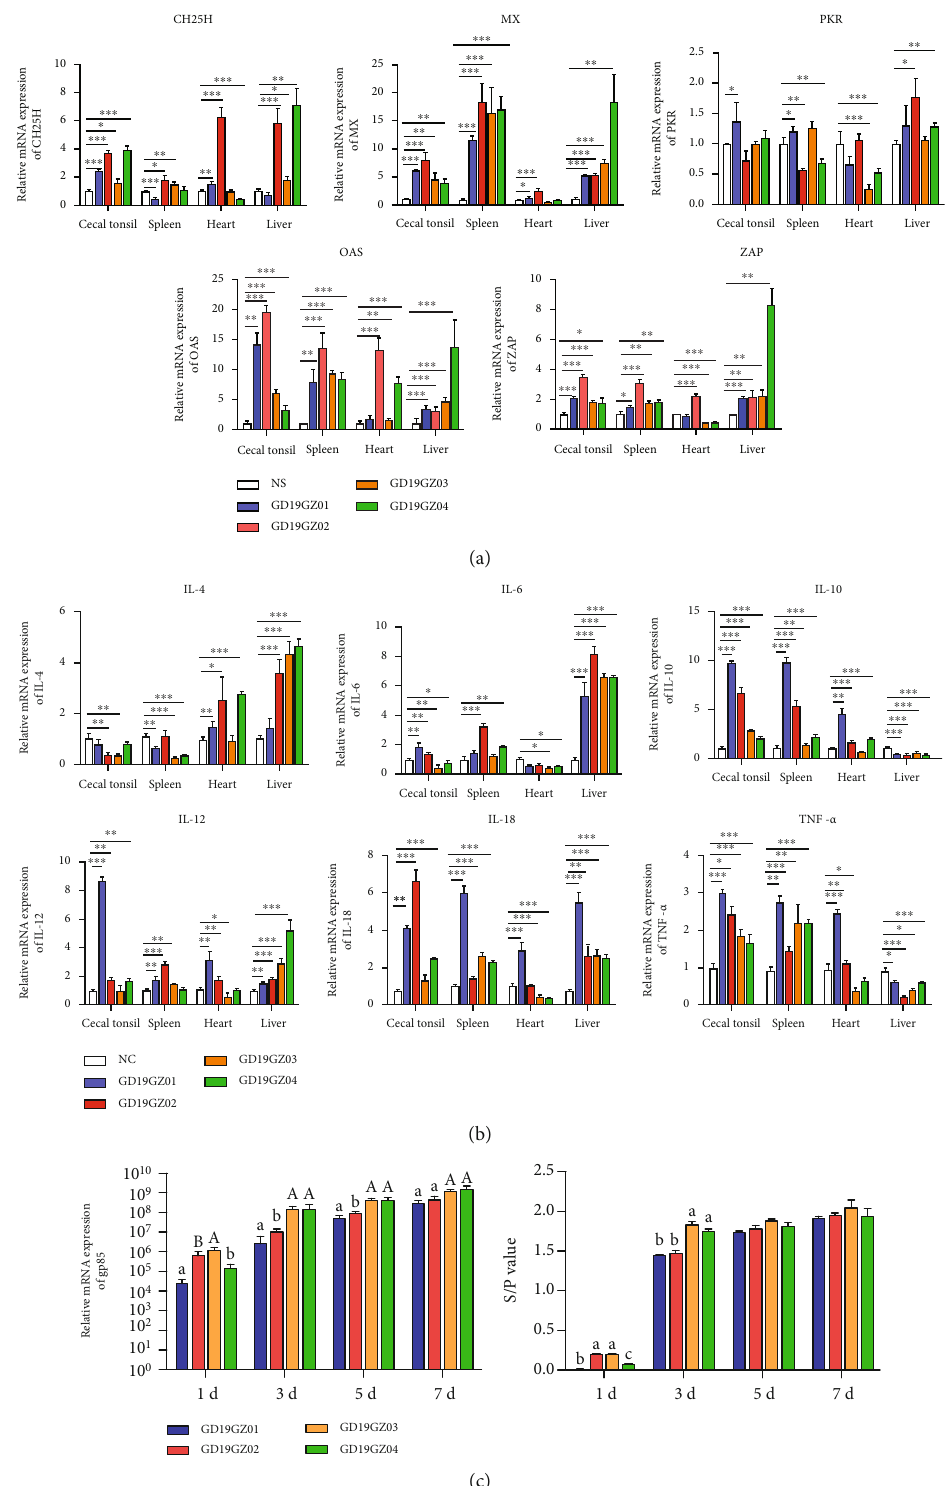
Figure 6: Expression of the innate immune genes and in fl ammatory cytokines in di ff erent organs of sick chickens and comparison of virus replication in vitro. The expression levels (a) of ISGs and (b) proin fl ammatory cytokines and anti-in fl ammatory cytokines in the immune organs. (c) Viral synthesis levels of the four isolates, as determined by qPCR and ELISA assays (the s/p value indicates the viral load). The data shown are the means ± SEM . The di ff erences with P < 0 : 05 were considered signi fi cant. ∗ P < 0 : 05 , ∗∗ P < 0 : 01 , ∗∗∗ P < 0 : 001 (a, b). Di ff erences within groups are marked with letters (A, a, B, b). The same letter means P < 0 : 05 , between di ff erent uppercase or lowercase letters means P < 0 : 01 , and between uppercase and lowercase letters means P < 0 : 001